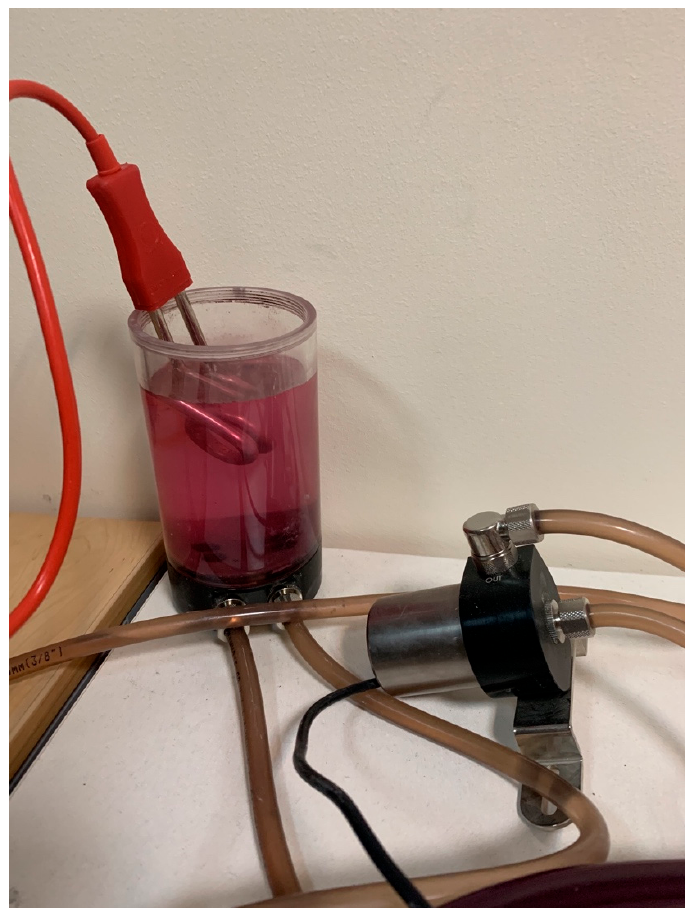
Figure 5. The heater element.